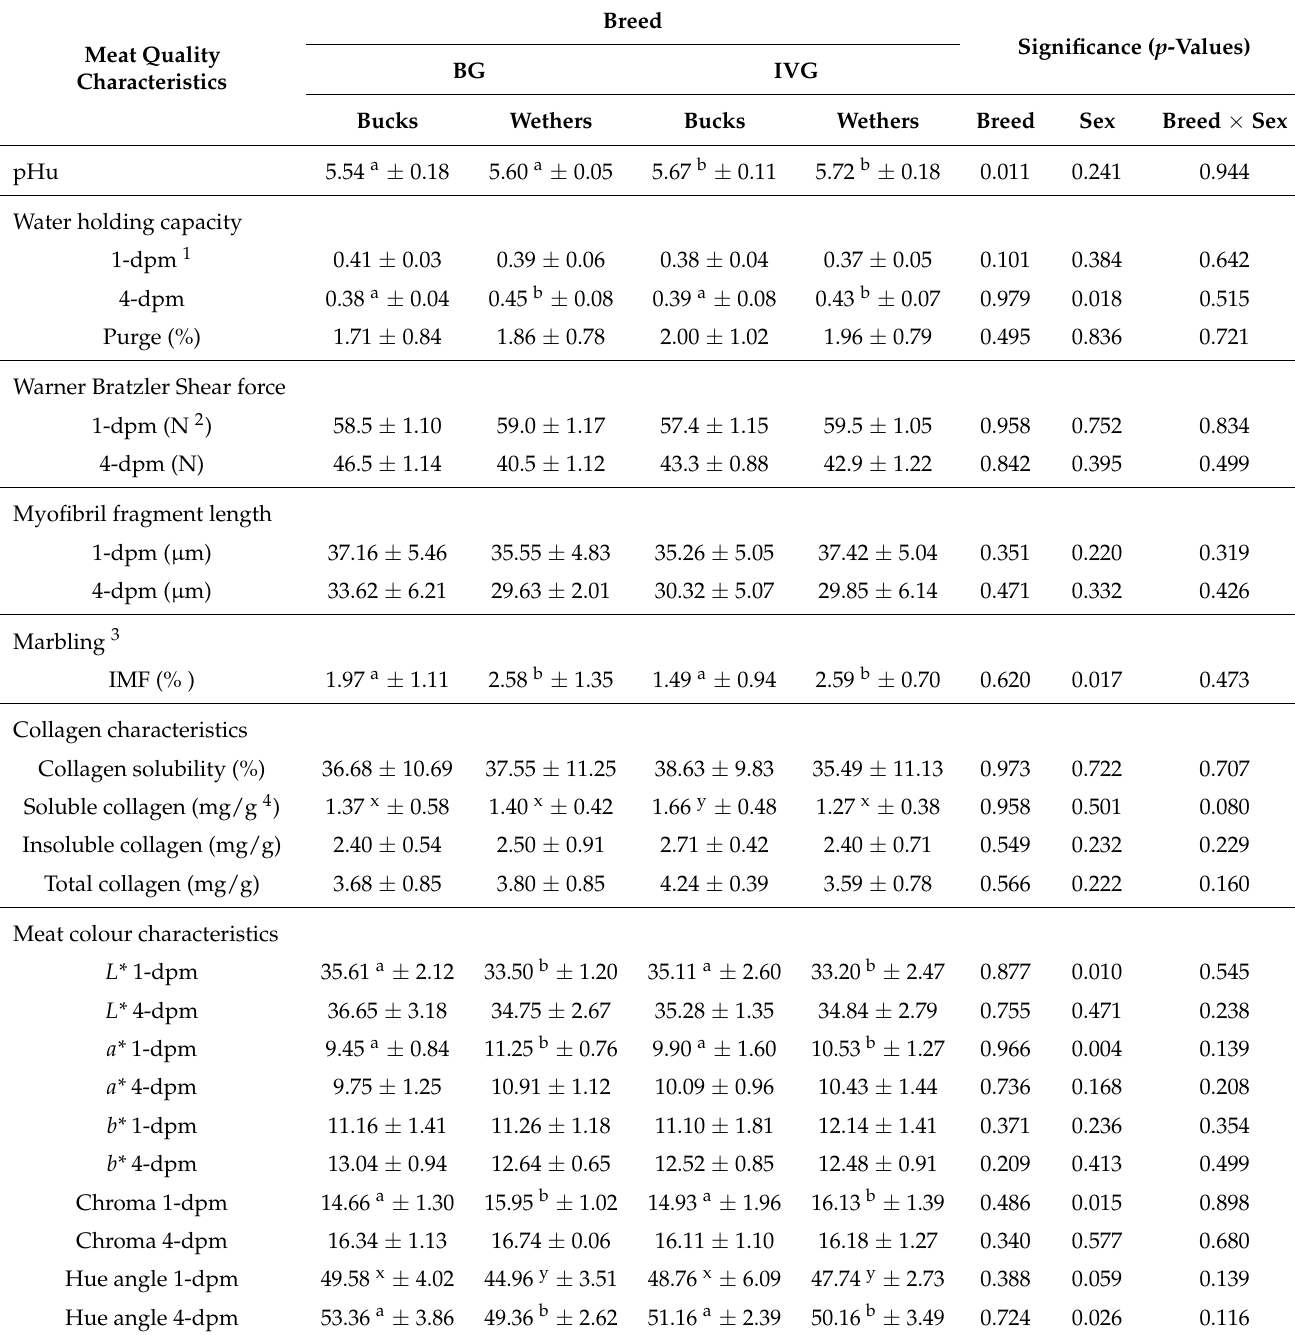
Table 2. Least square means and standard error of means for meat tenderness, meat colour and related physiological characteristics of buck and wether Boer Goats (BG) and Indigenous Veld Goats (IVG) of the Longissimus thoracis et lumborum (LTL)